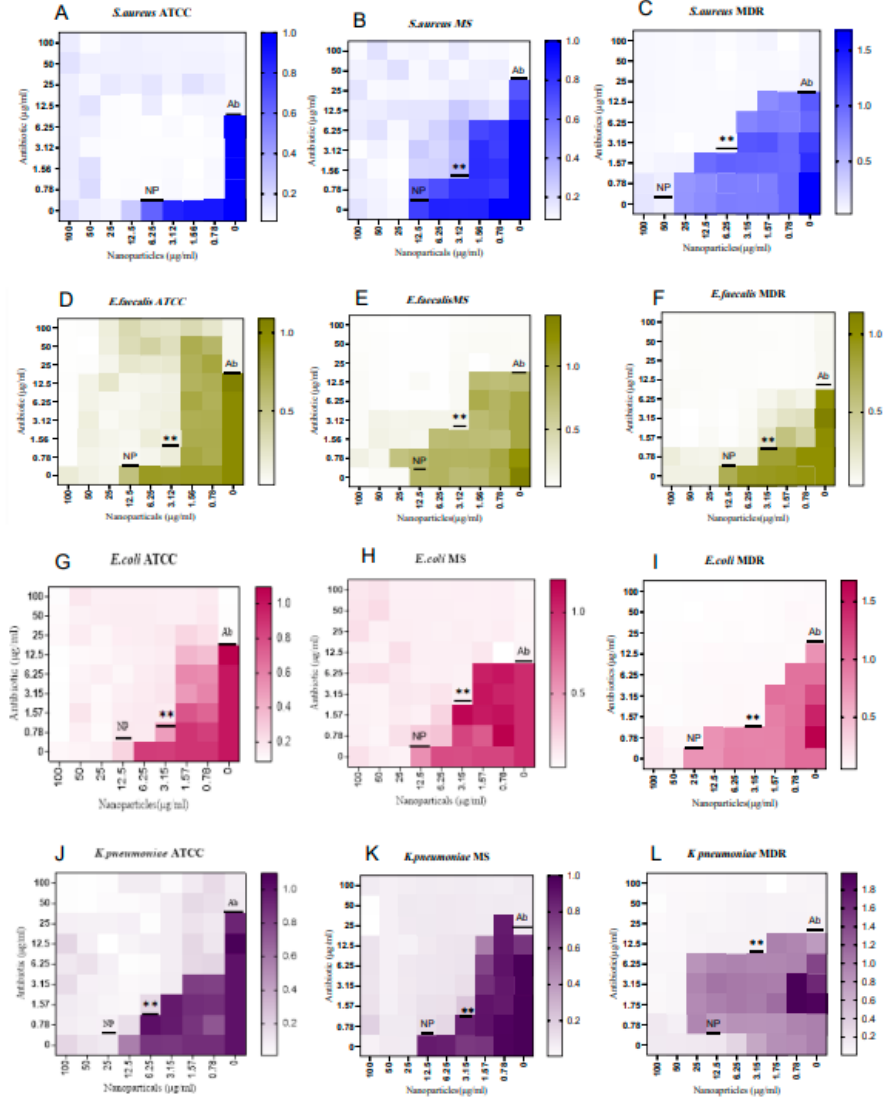
Figure 9. Synergistic, additive or antagonistic effect against AgPtNPs and antibiotics (ampicillin and vancomycin). ( A – C ) panels clarify the synergistic effect against S. aureus ATCC, MS and MDR bacterial strain. ( D − F) panels indicate the additive effect against E. faecalis ATCC, MS and MDR bacterial strains. ( G – I ) panels indicate the synergistic effect against E. coli ATCC, MS and MDR bacterial strains. Lastly, ( J – L ) panels indicate the additive and synergistic effects against K. pneumoniae ATCC, MS and MDR bacterial strain. NP: nanoparticles; Ab: antibiotic. Data are means of three independent experiments. Significant diff. among means **: p <